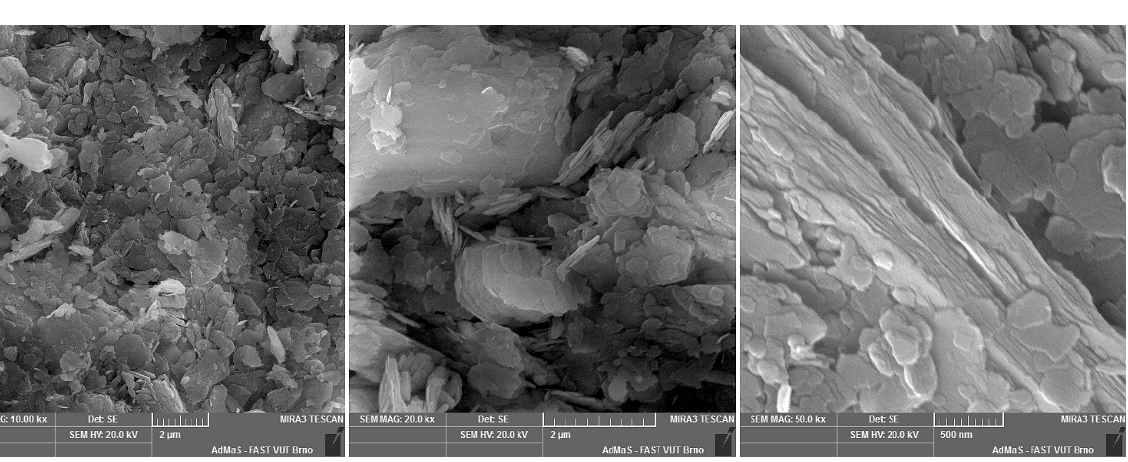
Figure A1. W-super claystone.